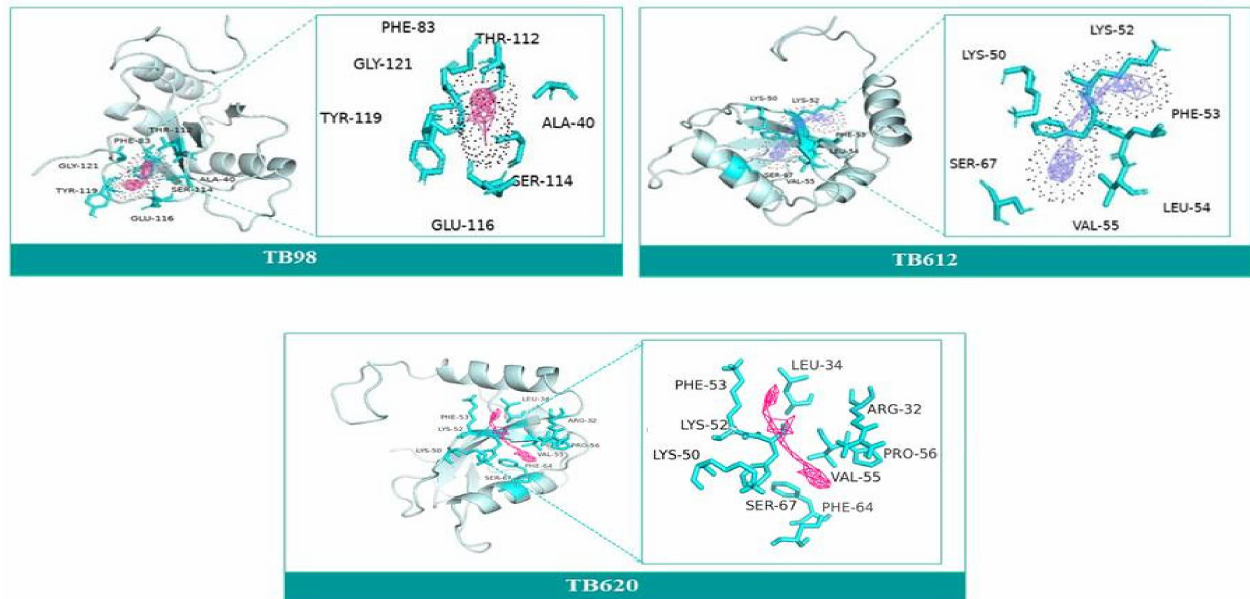
Figure 8. Top3HitsofThiabendazoleDerivativeswiththeirinteractingresiduesandDockedConformations.